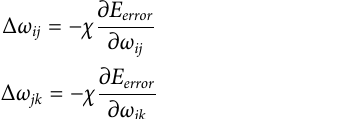
Frontiers in Materials |